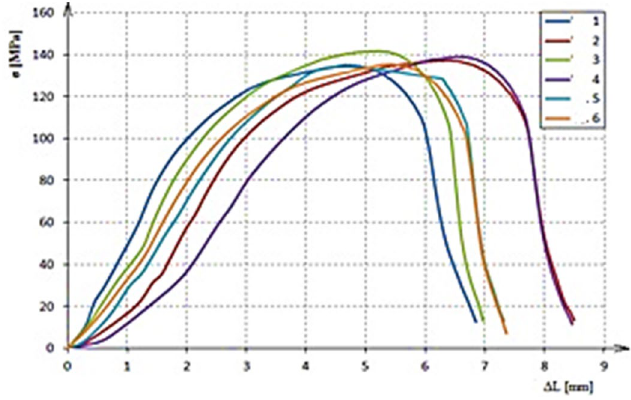
Figure 5. Tensile diagrams.